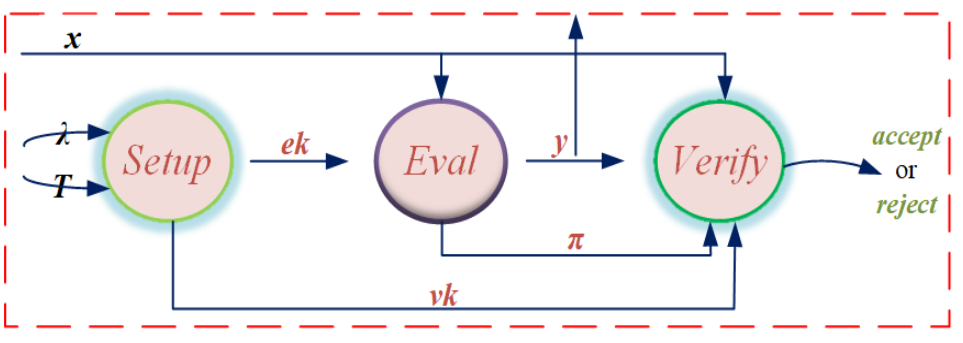
Figure 1. The algorithmic flow of verifiable delay